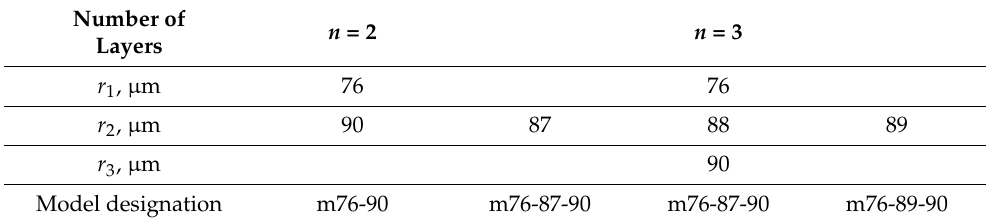
Table 1. Modeling parameters.